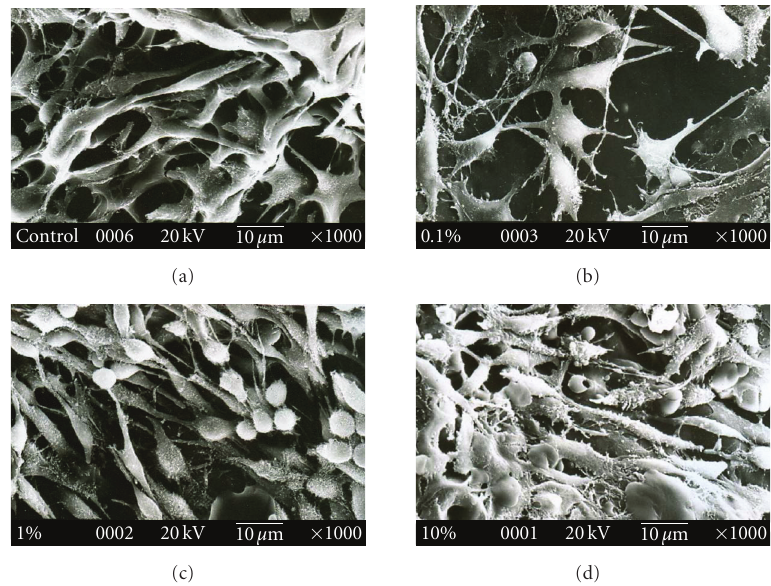
Figure 11: Scanning electron micrograph of mouse L929 cells cultured on PLGA microsphere incorporated gelatin sca ff old after 3 days of initial seeding. (a) Gelatin sca ff old, (b) 0.1% w/w PLGA microsphere loaded sca ff old, (c) 1%w/w PLGA microsphere loaded sca ff old, and